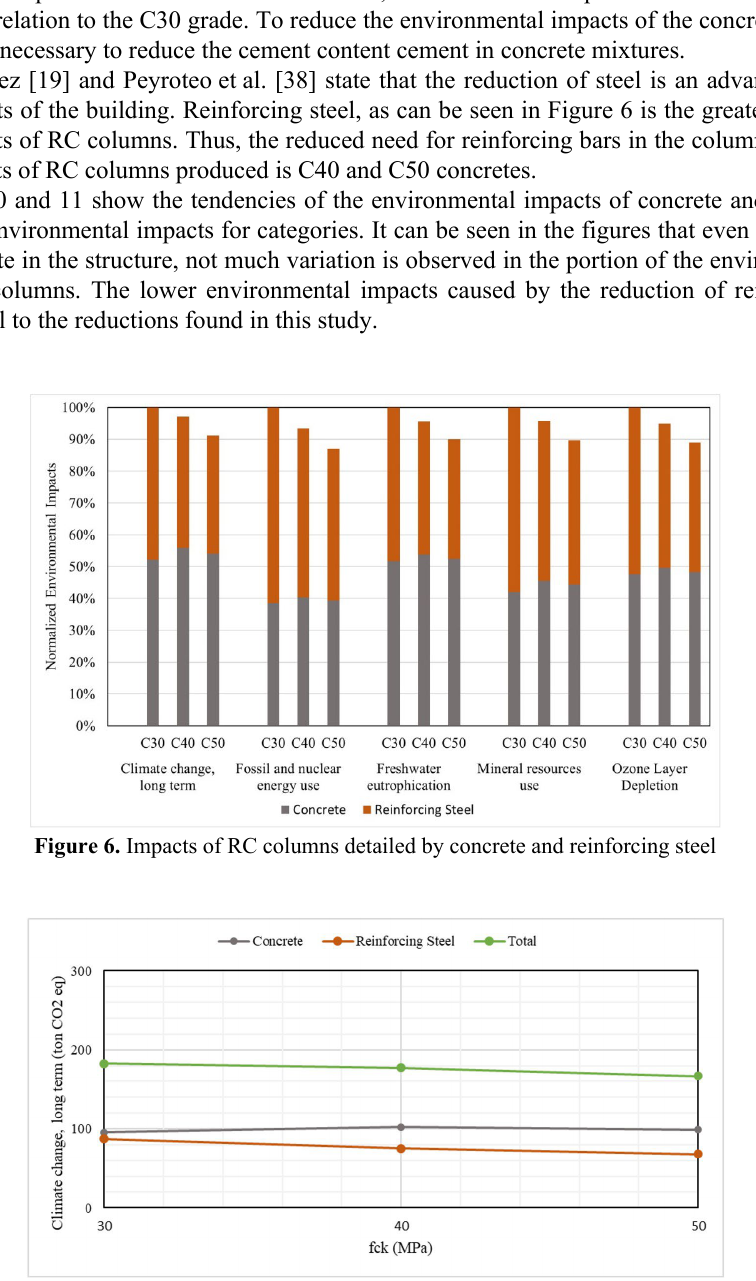
Figure 7. Climate change, long-term impacts for RC